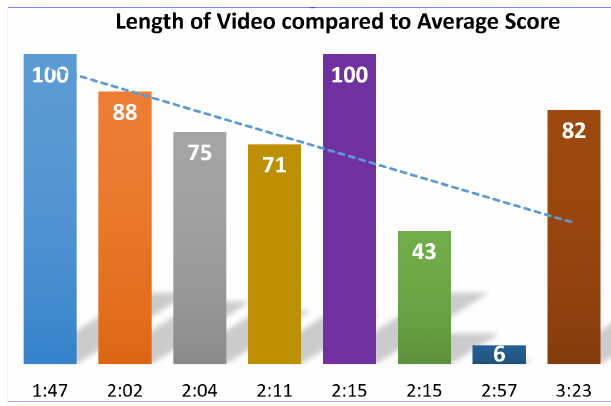
Fig. 2. Video length compared to Average